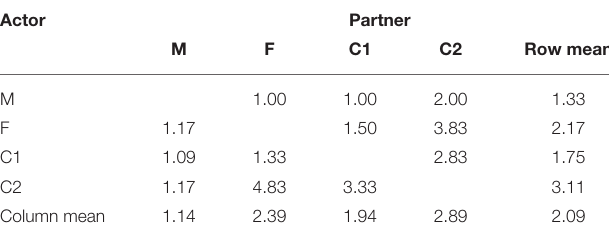
TABLE 3 | Raw dyadic scores according to a two-way ANOVA design (M, mother; F, father; C1, oldest child; C2, youngest child). Actor